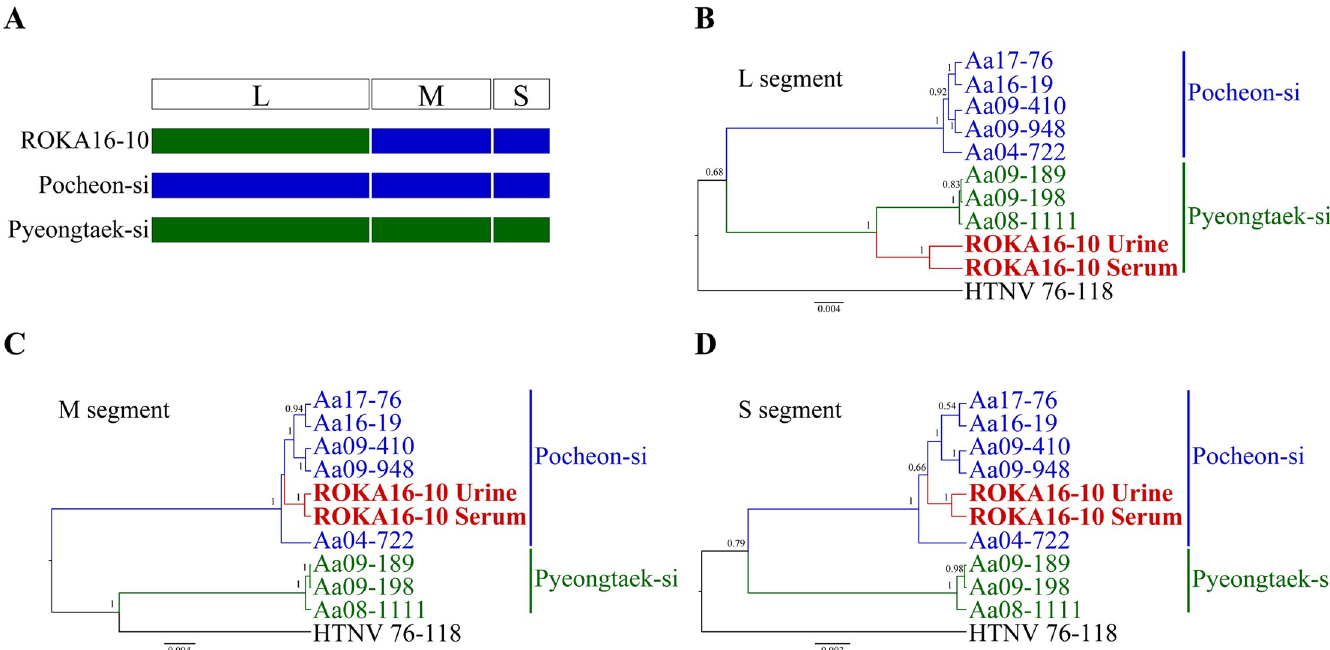
Fig 3. Evidence of a reassortment event in Hantaan virus (HTNV) on patient ROKA16-10 in Pocheon-si. (A) The Bootscan plot was based on a pairwise distance model using the RDP4 algorithm. Green and blue colors represent the comparison of ROKA16-10 (Pocheon-si) to Pyeongtaek-si and Pocheon-si groups, respectively. (B-D) Phylogenetic trees are shown for the L, M, and S segments of the reassortant ROKA16-10 using Bayesian inference in BEAST